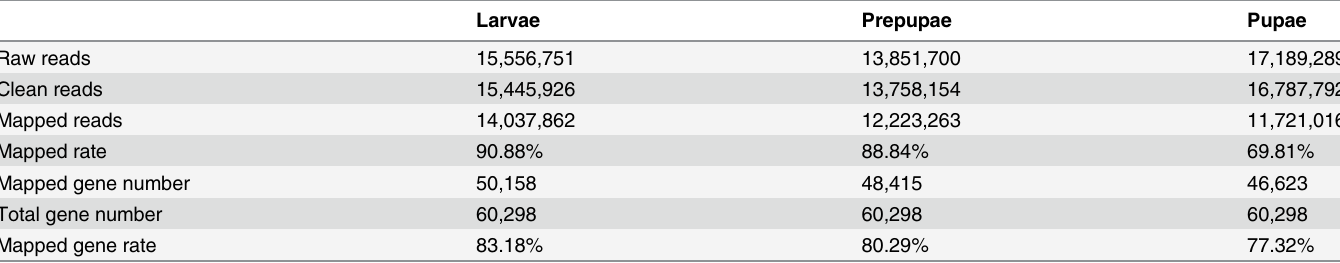
Table 2. Summary statistics of RNA-seq library sequencing and